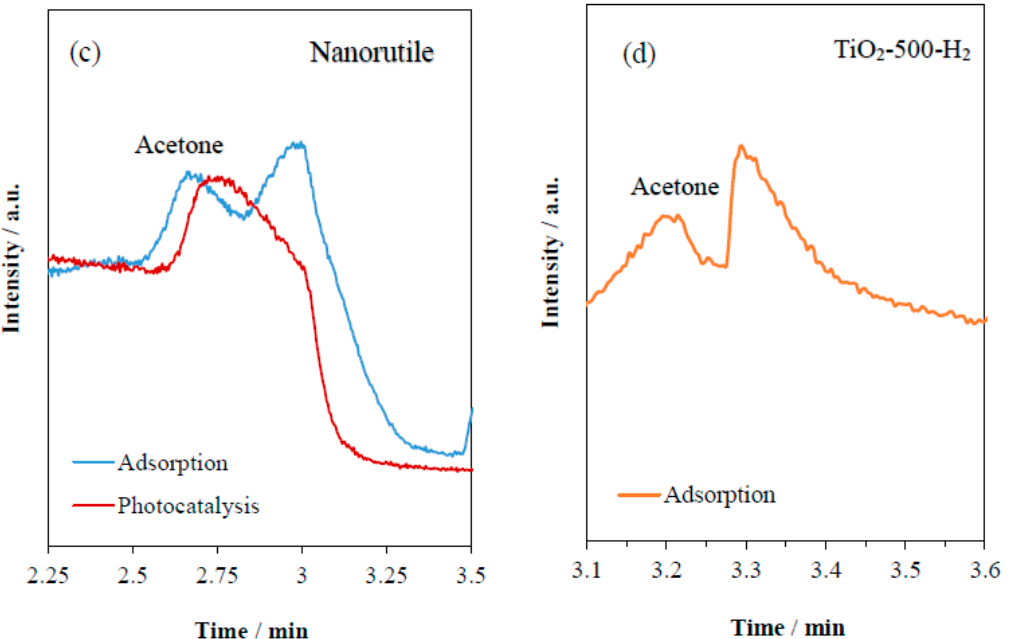
Figure 11. Thermal desorption peaks from titania samples heated up to 250 °C: ( a ) after adsorption of acetaldehyde, ( b ) after photocatalytic decomposition of acetaldehyde, ( c ) nanorutile, and ( d ) TiO 2 -500-H 2.